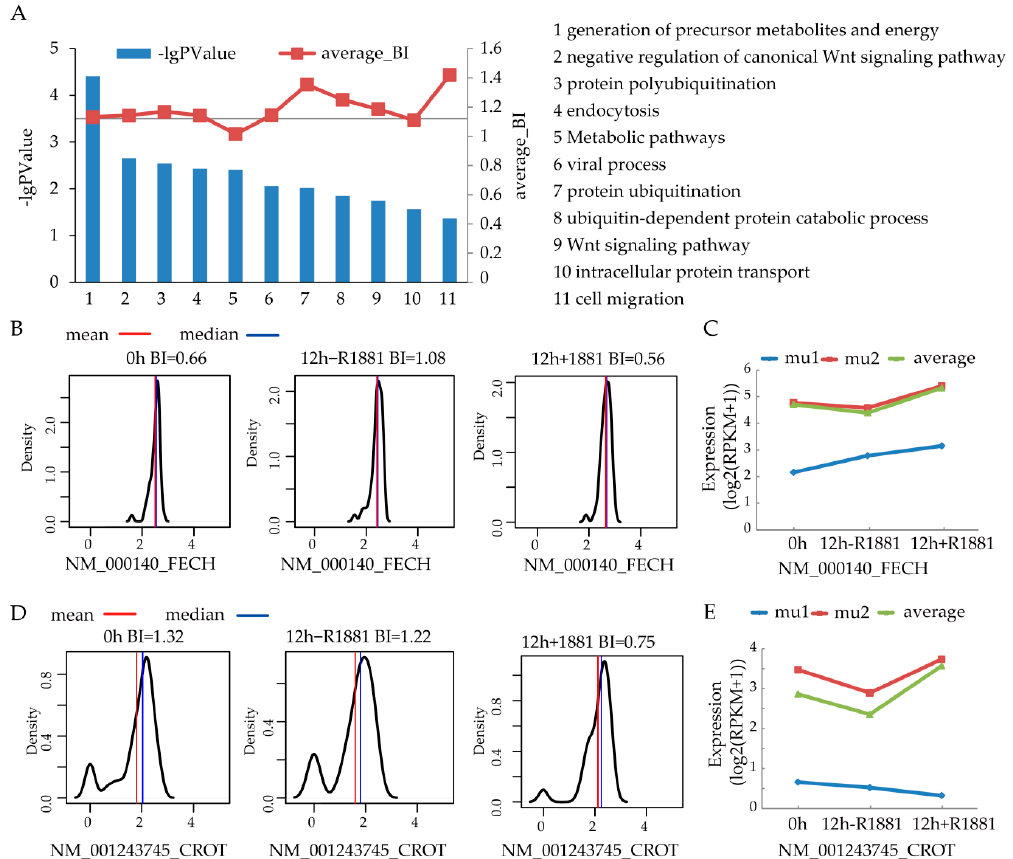
Figure 4. Interested functional terms and genes. ( A ) The significantly enriched terms with high BI value. The bar represents the minus log10 p- value of enrichment significance. The text on the right is the names of terms corresponding to x-axis in the bar chart; ( B ) Expression trend of FECH; ( C ) Subpopulation expression of FECH; ( D ) Expression trend of CROT; ( E ) Subpopulation expression of CROT.